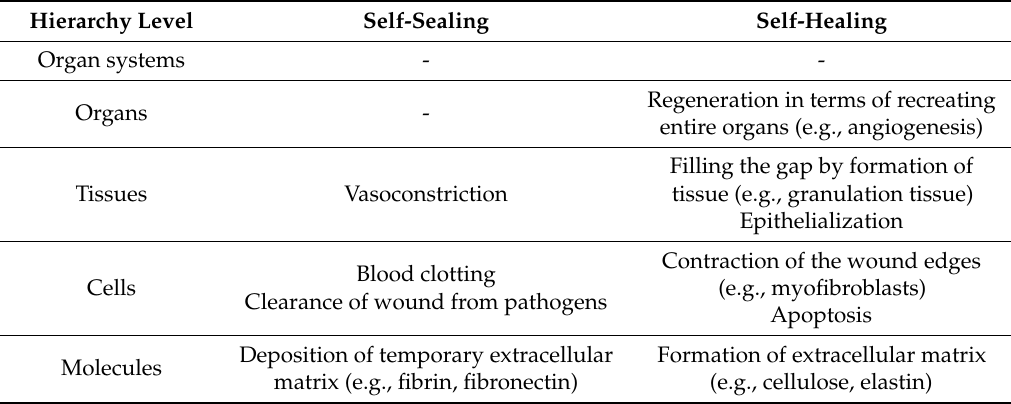
Table 3. Overview of common self-repair mechanisms found in human wound reaction arranged according to increasingly smaller hierarchy